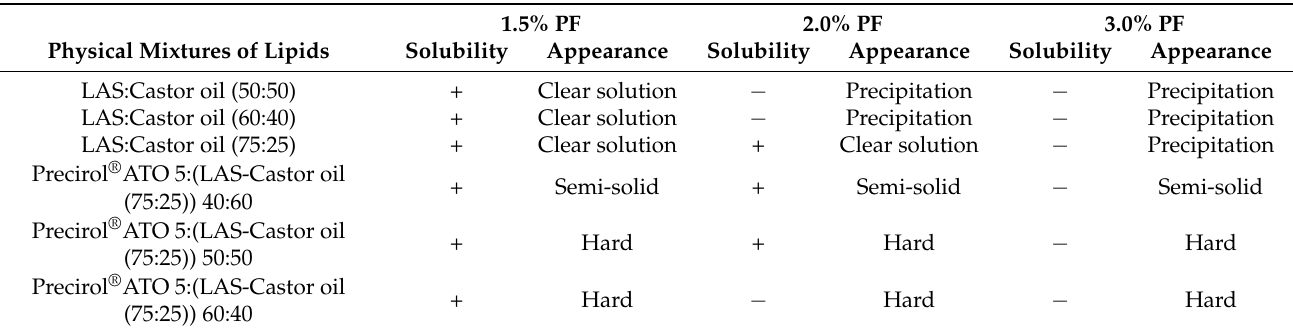
Table 2. Solubility of pranoprofen in mixtures of